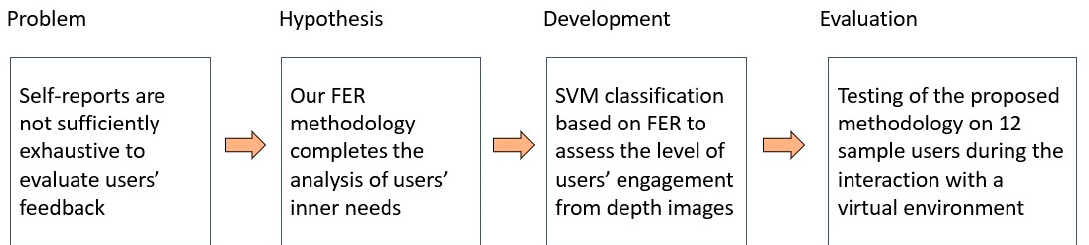
Figure 1. Schematization of design science research (DSR) approach.